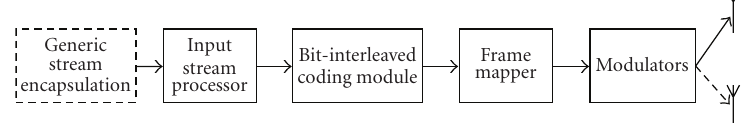
Figure 1: Overview of DVB-T2